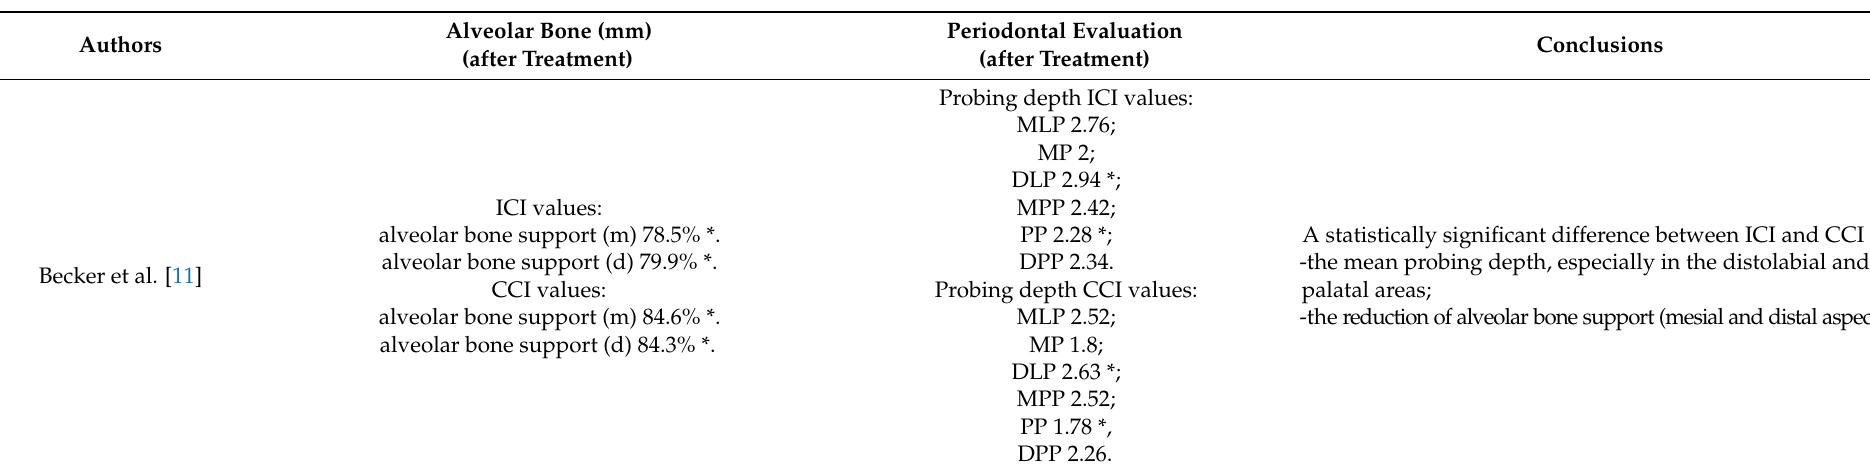
Table 4. Summary of the results of the included studies (alveolar bone and periodontal